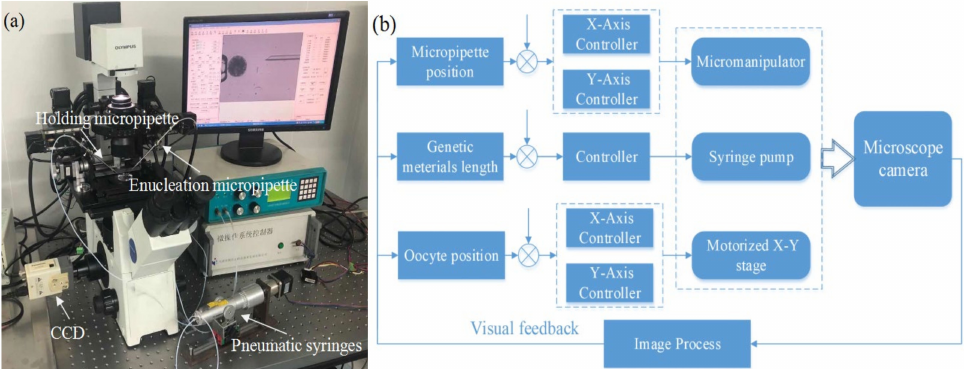
Figure 7. ( a ) NK-MR601 micro-operation system. ( b ) System control architecture.